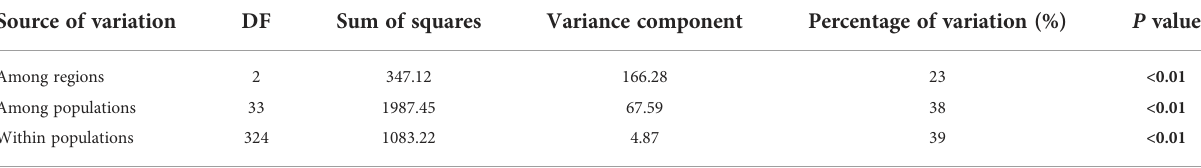
TABLE 3 Analysis of molecular variance (AMOVA) results of E. annuus populations based on microsatellite markers. Source of variation DF Sum of squares Variance component Percentage of variation (%) P value Among regions 2 347.12 Among populations Within